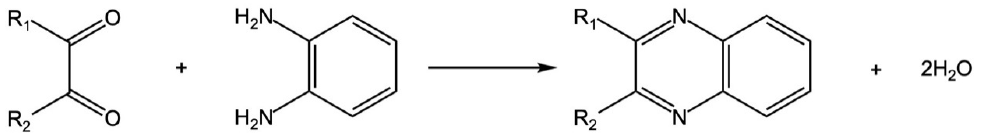
Figure 1. The reaction equation of OPD and α -DCs. Figure 3. The relative content of phenylacetaldehyde produced by different reaction ratios of glucose and